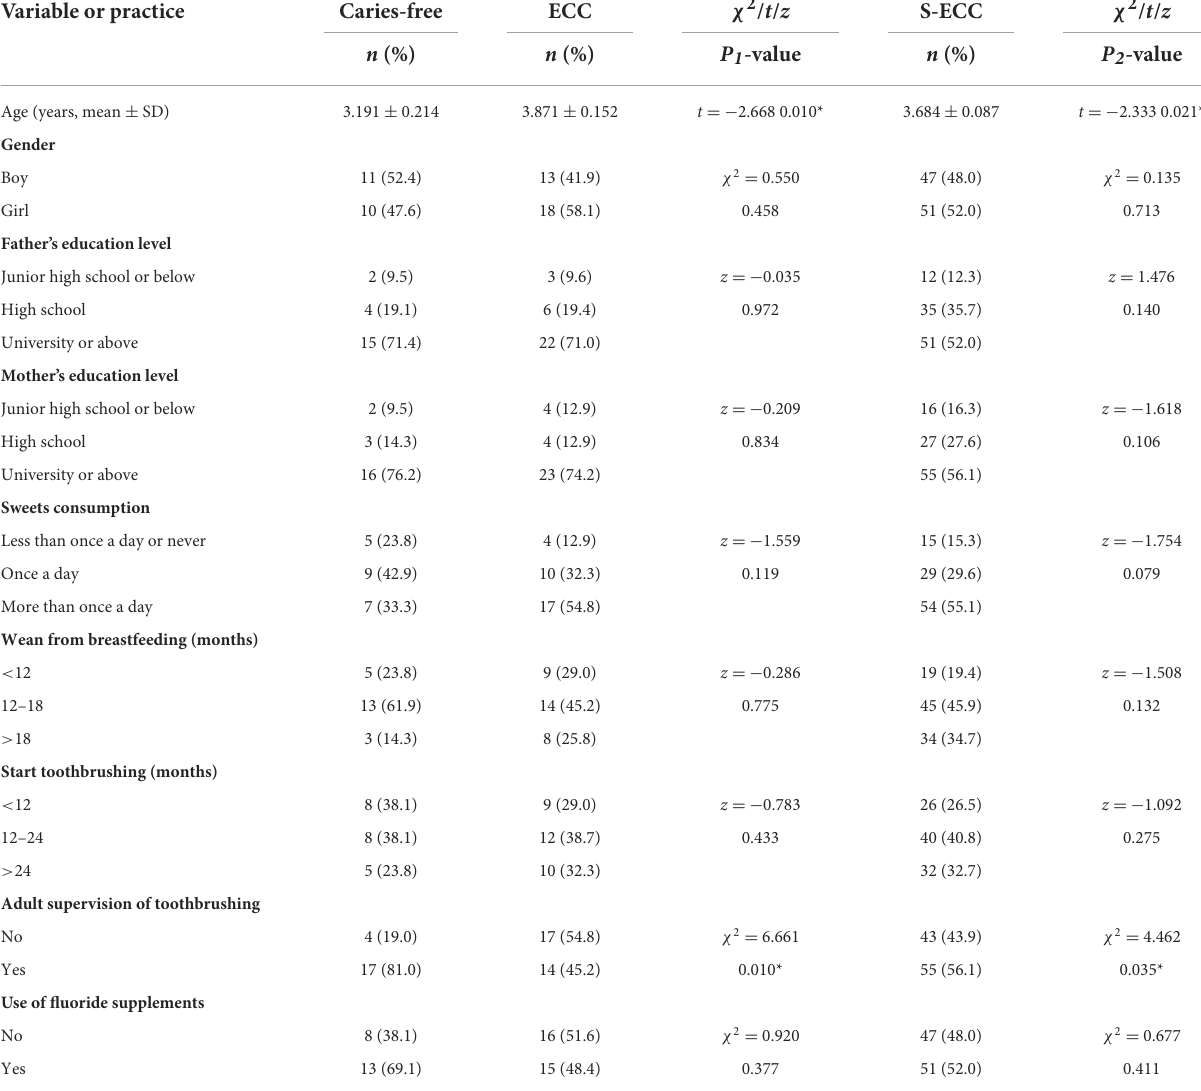
TABLE 1 The general characteristics and oral health behaviors of study participants with the presence or absence of ECC and S-ECC. Variable or